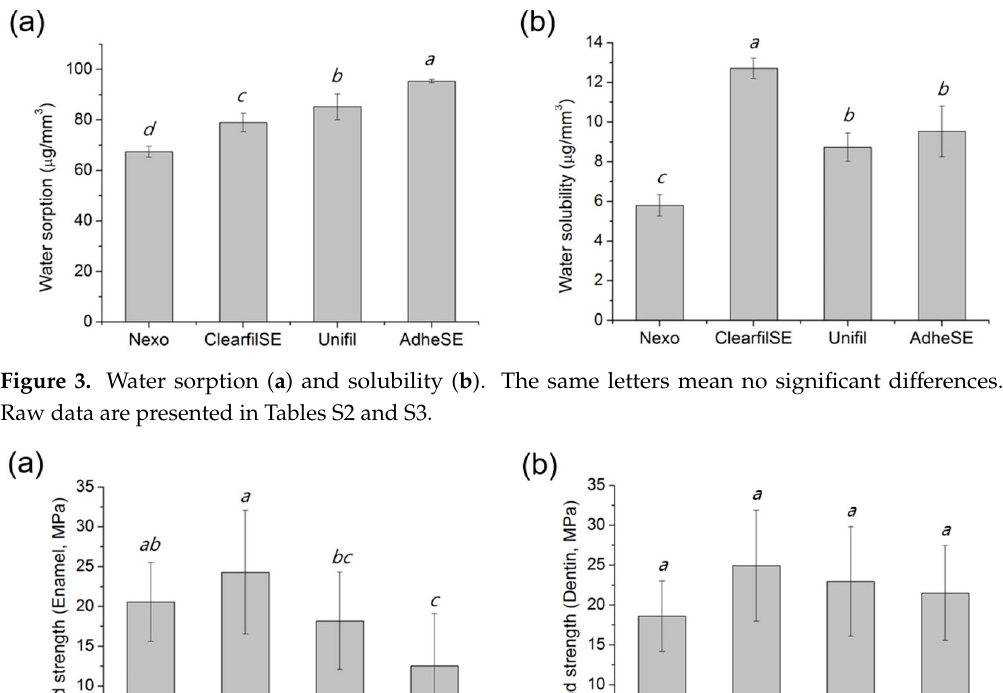
Figure 2. Thickness of bonding agent ( μ m). The same letters mean no significant differences. Raw data are presented in Table S1.